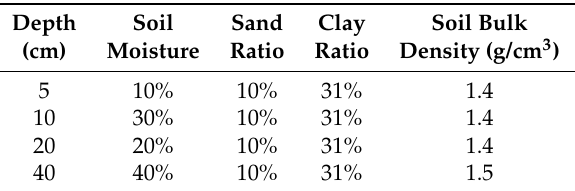
Table 1. Example soil moisture profile